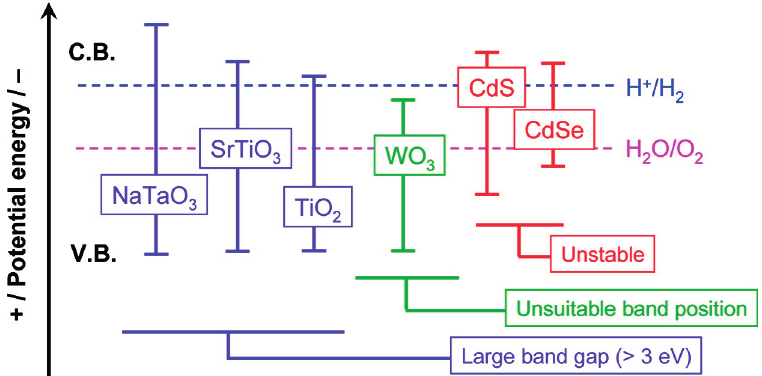
Figure 8. Band gap energies and band edge potentials for different photocatalytic materials with respect to the water splitting couples (with permission from Maeda, K.; Domen, K. New Non-Oxide Photocatalysts Designed for Overall Water Splitting under Visible Light. J. Phys. Chem. C 2007 , 111 , 7851–7861